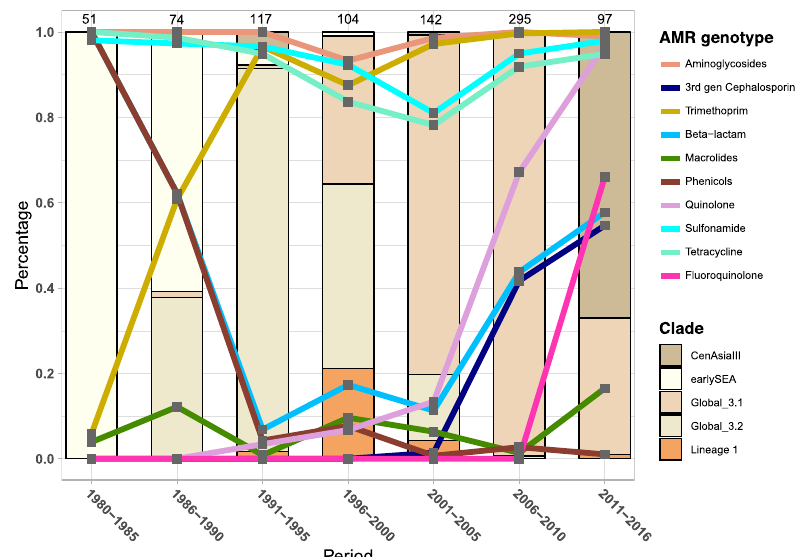
Fig. 5 Clonal replacement of Shigella sonnei in Southeast Asia. The fi gure shows the isolation frequency of S. sonnei lineages from 1980 to 2016 from all countries across Southeast Asia (Thailand, Vietnam, Cambodia, Laos). Isolates of Lineage 1 and earlySEA are mostly restricted to North Vietnam and Thailand, respectively. The bar chart displays the proportional sampling of these lineages compared with the total S. sonnei isolated during a period (total number of isolates indicated on top of each bar). The percentage of S. sonnei isolates resistant to a given antimicrobial, determined by identi fi cation of AMR genetic factors, is plotted by line graph. The y -axis (percentage) is used to measure both the isolation proportion of S. sonnei populations and proportion with resistance to speci fi ed